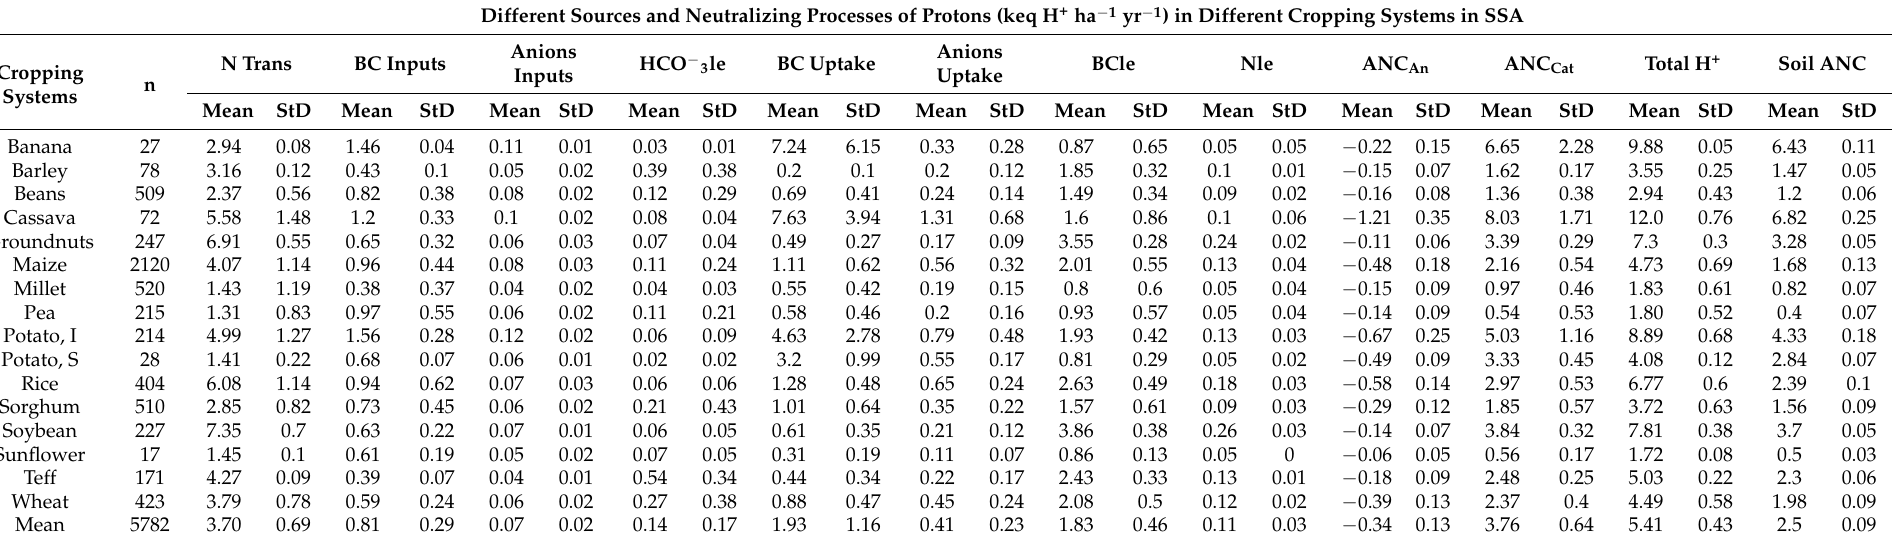
Table 3. Descriptive statistics of annual proton (H + ) production rates for the main cropping systems in Sub-Saharan